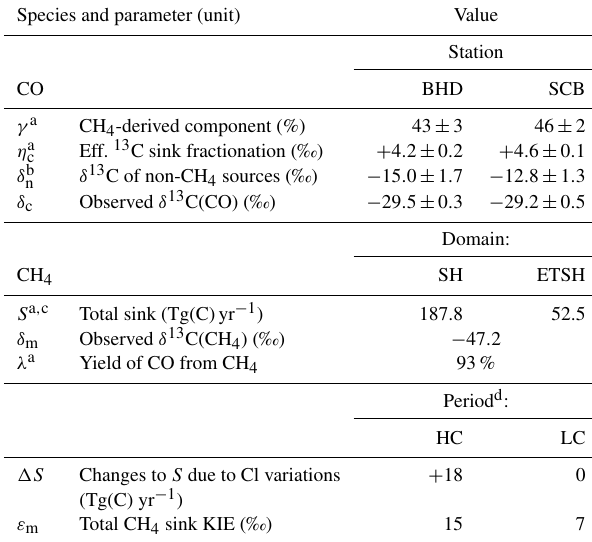
Table 2. Parameters used in